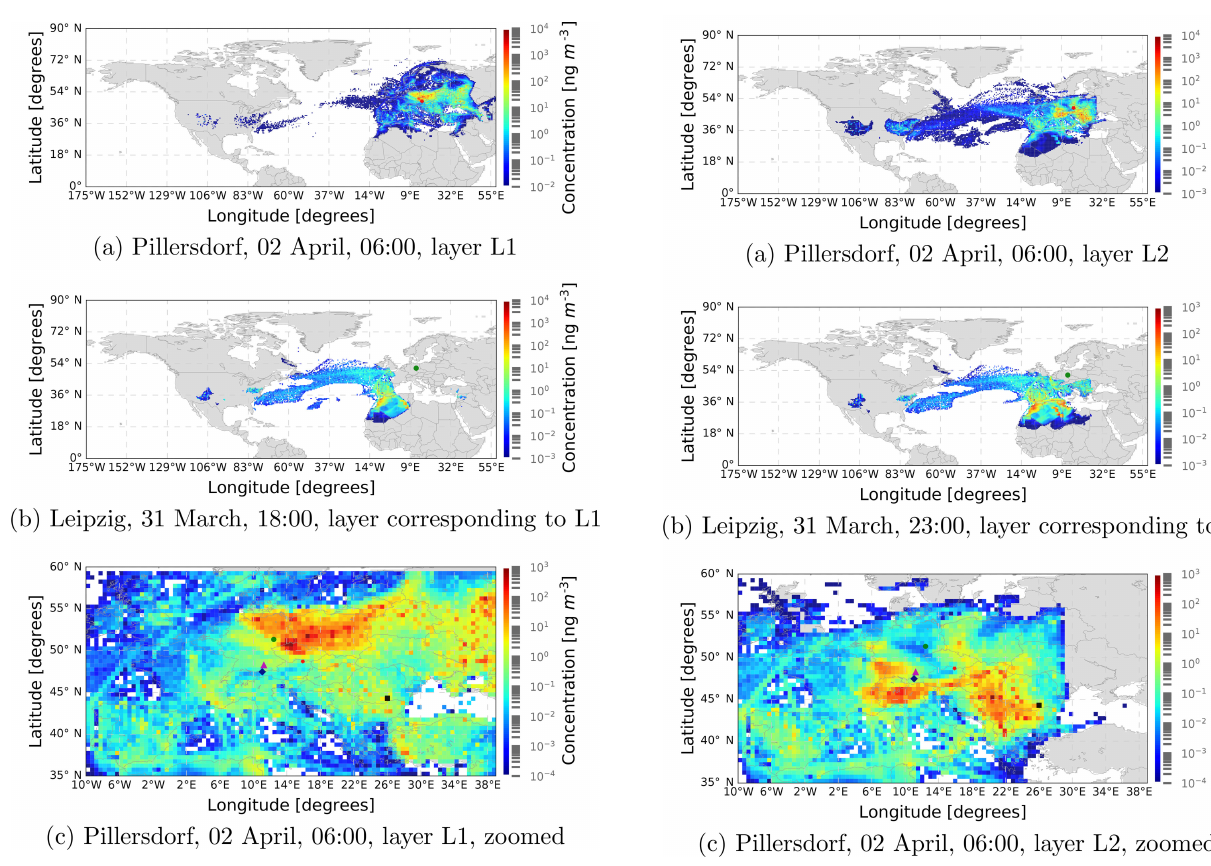
Figure 10. Relative distributions of SO 2 sources for Pillersdorf layer L1 (a) , Leipzig (b) ; zoomed distribution for Pillersdorf layer L1 (c) .